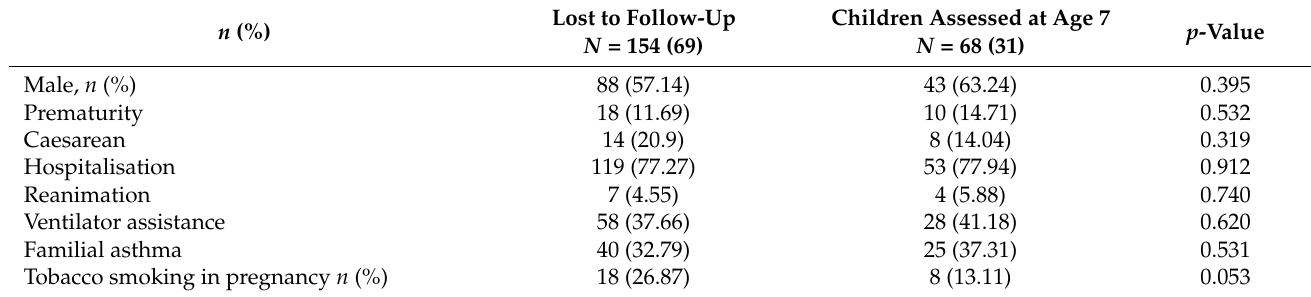
Table 1. Characteristics of the population: children lost to follow-up/children assessed at age